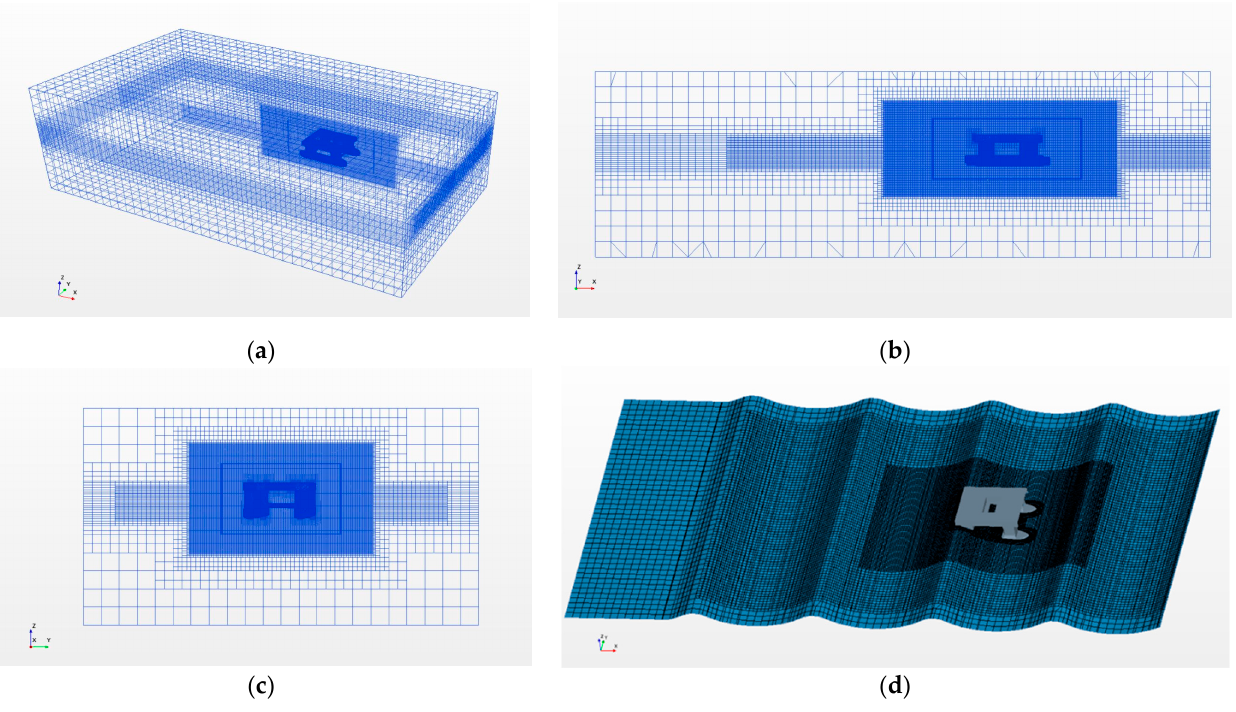
Figure 10. ( a ) A 3D view of the grid; ( b ) Grid view of x–z cross-section; ( c ) Grid view of y–z cross-section; ( d ) Grid division of the free surface.